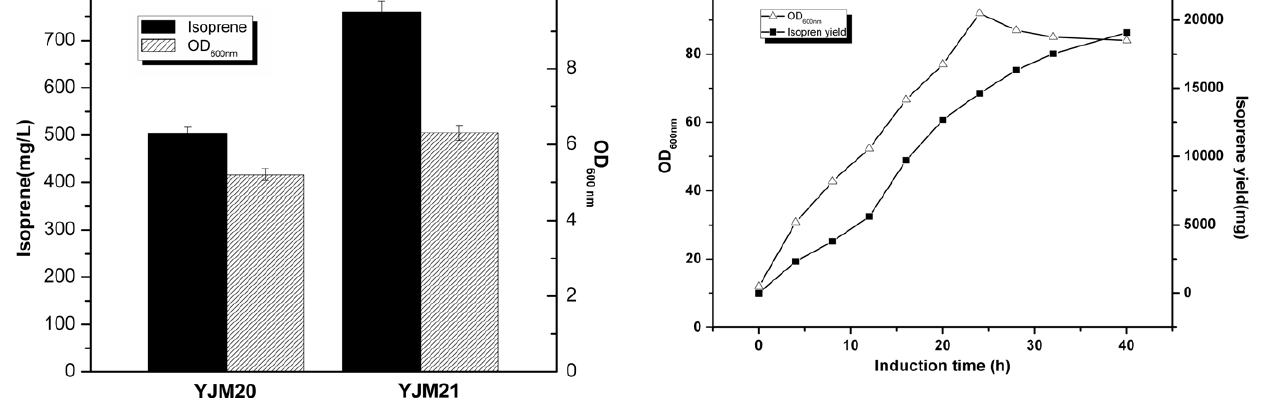
Figure 5. Comparison of isoprene production from different recombinant strains. The experiment was conducted under flask conditions in triplicate.